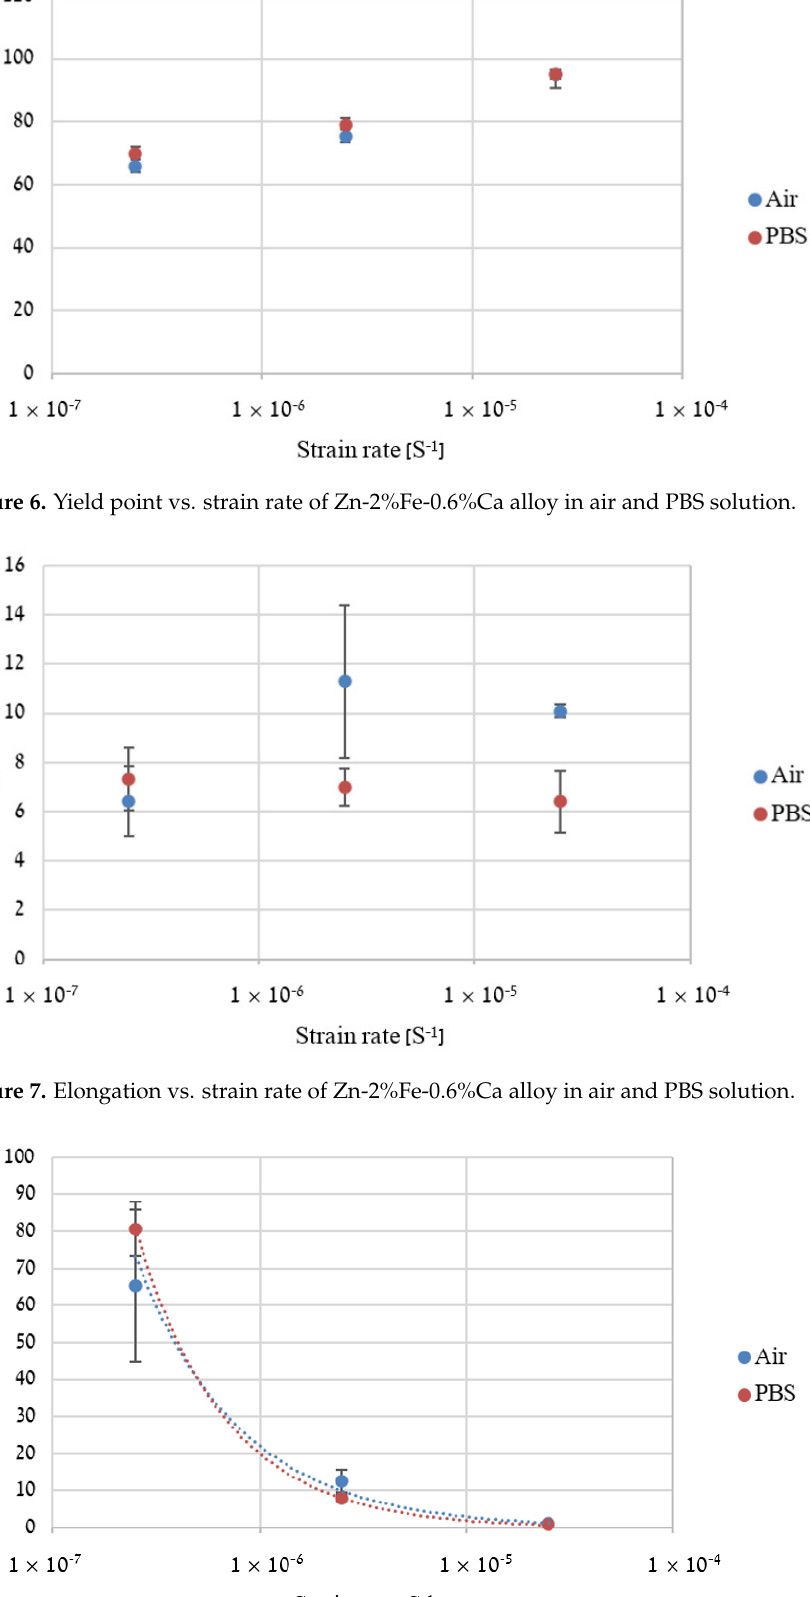
Figure 5. UTS Vs. strain rate of Zn-2%Fe-0.6%Ca alloy in air and PBS solution.